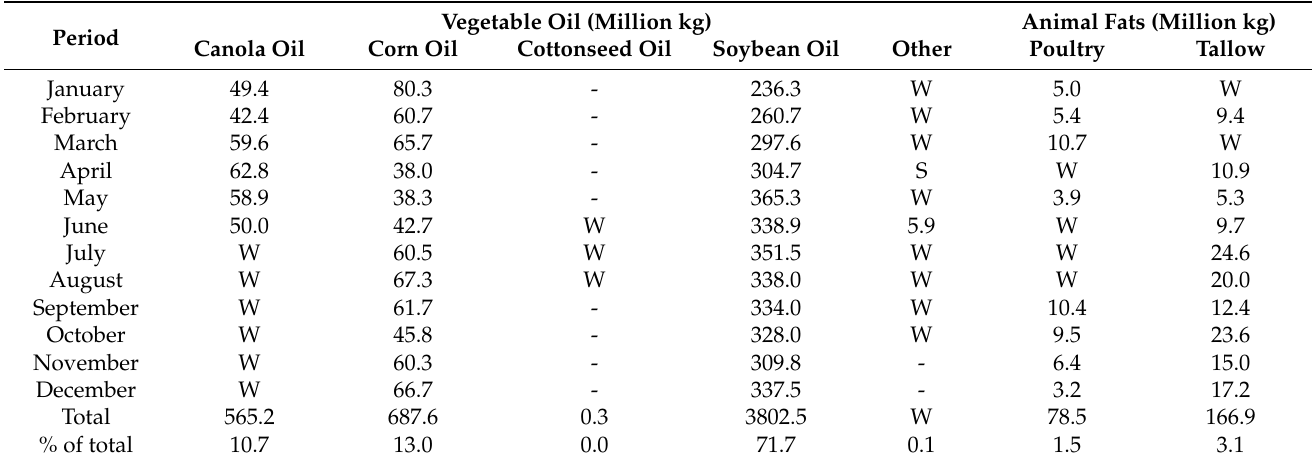
Table with -, W, S indicates no data, withheld to avoid disclosure of individual company data, and value is less than 0.5 of the table metrics. However, the value is included in any associated total. Source: U.S. Energy